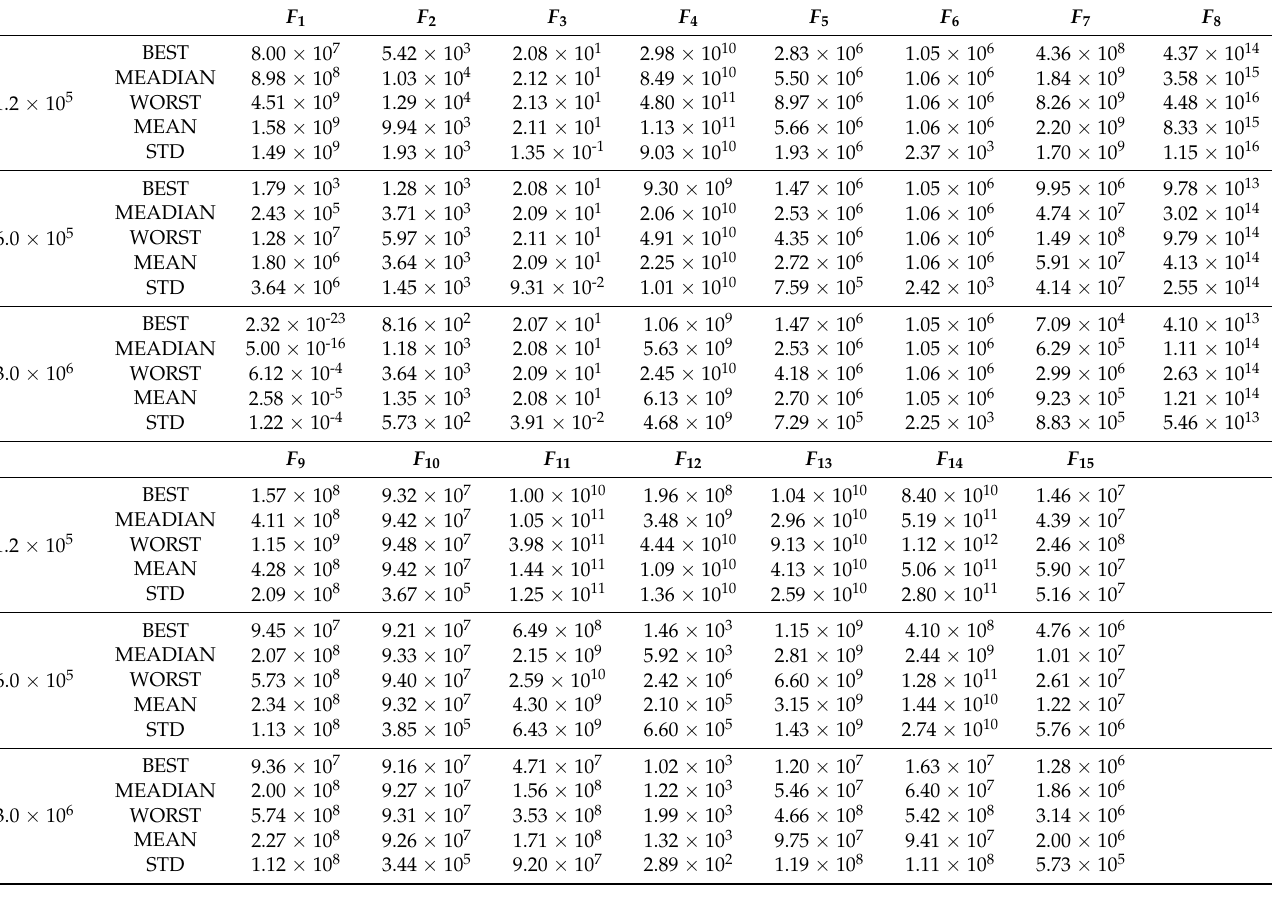
Table 10. Detailed results for the fine-tuned CC-SHADE-ML algorithm.